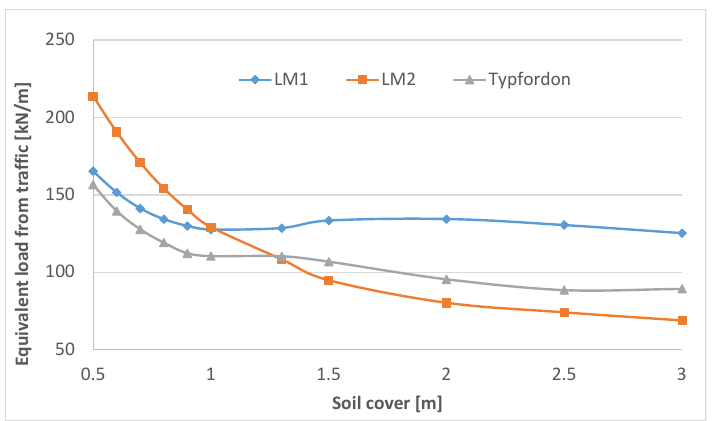
Figure 8. Three load models converted into equivalent line loads regarding different soil cover heights.